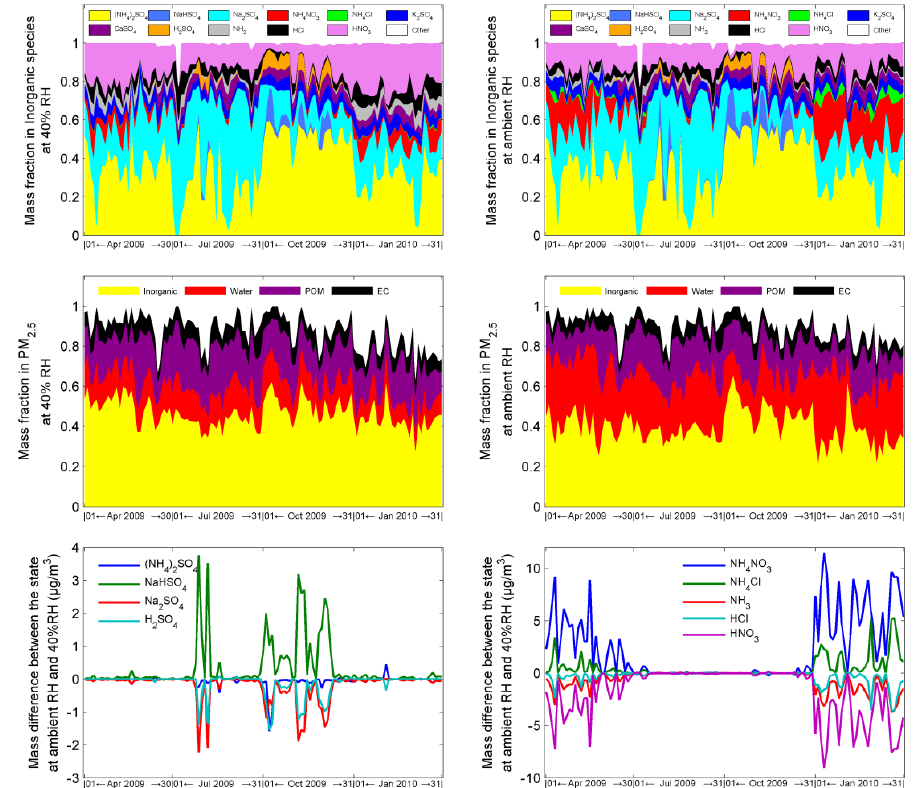
Figure 3 Chemical composition of PM Fig. 3. Temporal variations of chemical composition of PM 2 . 5 at 40% RH and ambient 389